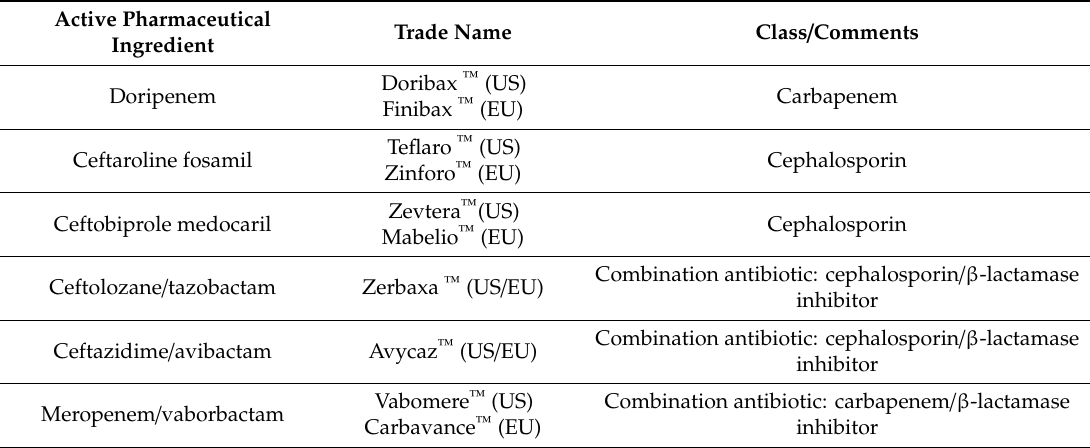
Table 1. Antibiotics recently approved by the Food and Drug Administration (FDA) and / or European Medicines Agency